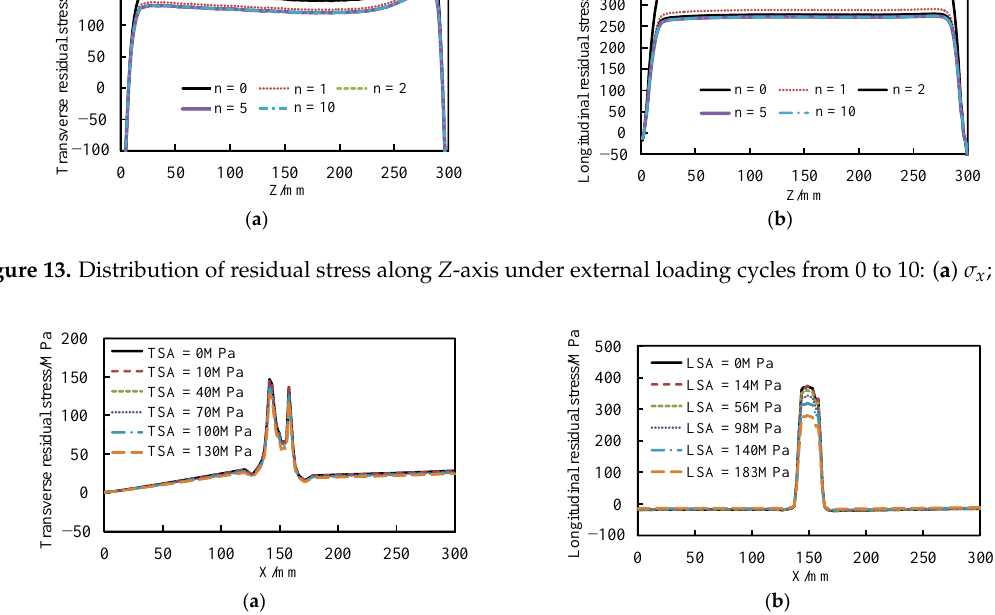
Figure 14. Distribution of residual stress along X -axis under TSA from 0 MPa to 130 MPa: ( a ) σ x ; ( b ) σ z .